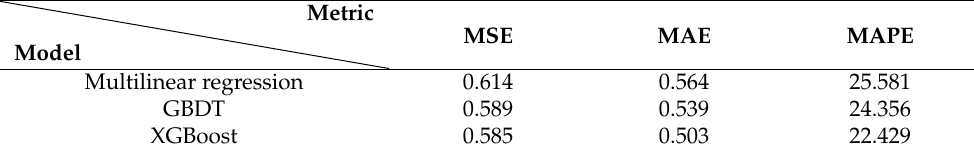
Table 7. The metric values of the three